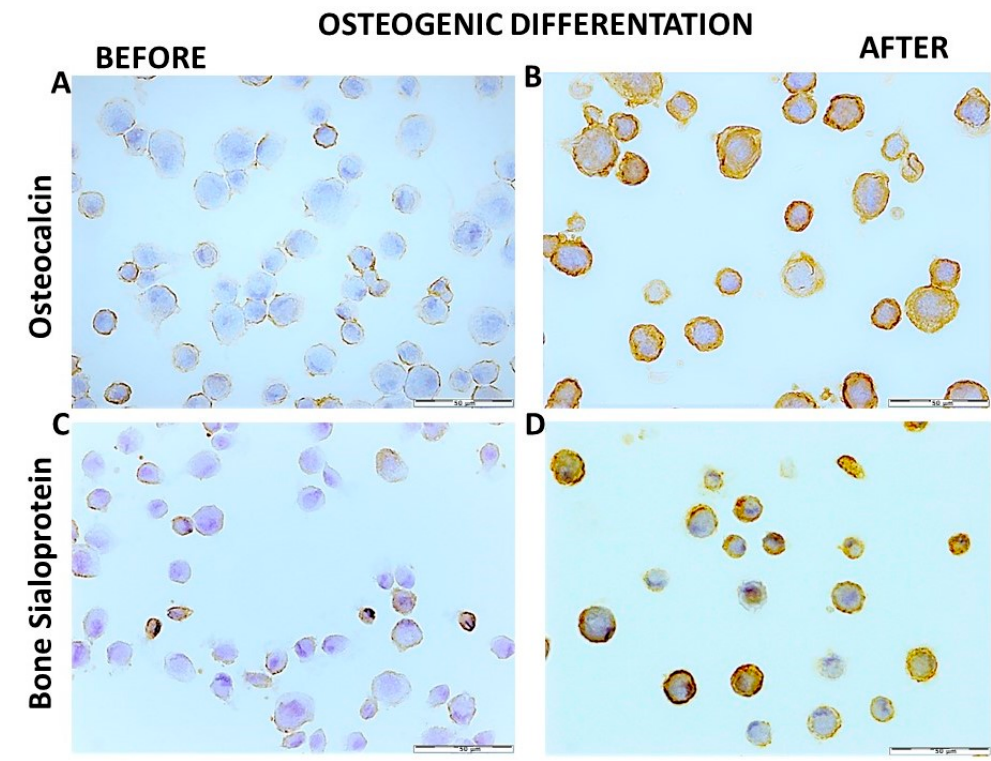
Figure 9. Comparison of bone-related proteins expressed by hDPSCs grown on PLCL nonfibrous scaffold before and after osteogenic differentiation. ( A ) Cytospin specimens of hDPSCs showed weak expression of OCN before ( B ) and high OCN expression after osteogenic differentiation. ( C ) hDPSCs demonstrated low expression of BSP before ( D ) and intensive expression of BSP on hDPSCs after differentiation. (EnVision technique). Scale bar = 50 μ m.